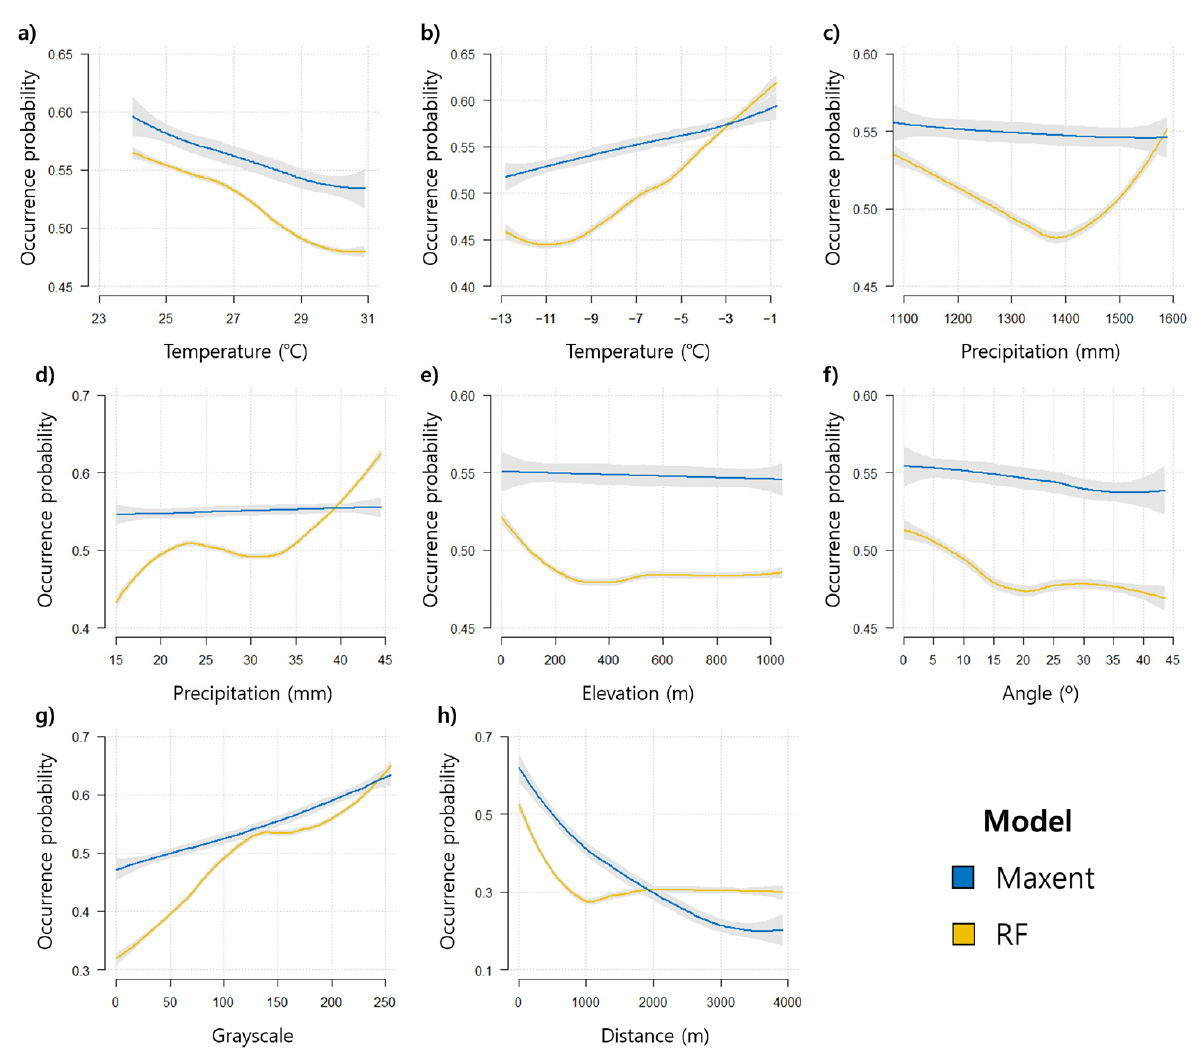
Figure 5. Partial dependence plots of both the SDMs for WCSBs. Solid lines are regression curves using LOESS, and gray areas display the 95% confidence interval. ( a ) Maximum temperature of the warmest month, ( b ) minimum temperature of the coldest month, ( c ) annual precipitation, ( d ) precipitation of driest month, ( e ) elevation, ( f ) slope, ( g ) night light, ( h ) distance to the road.